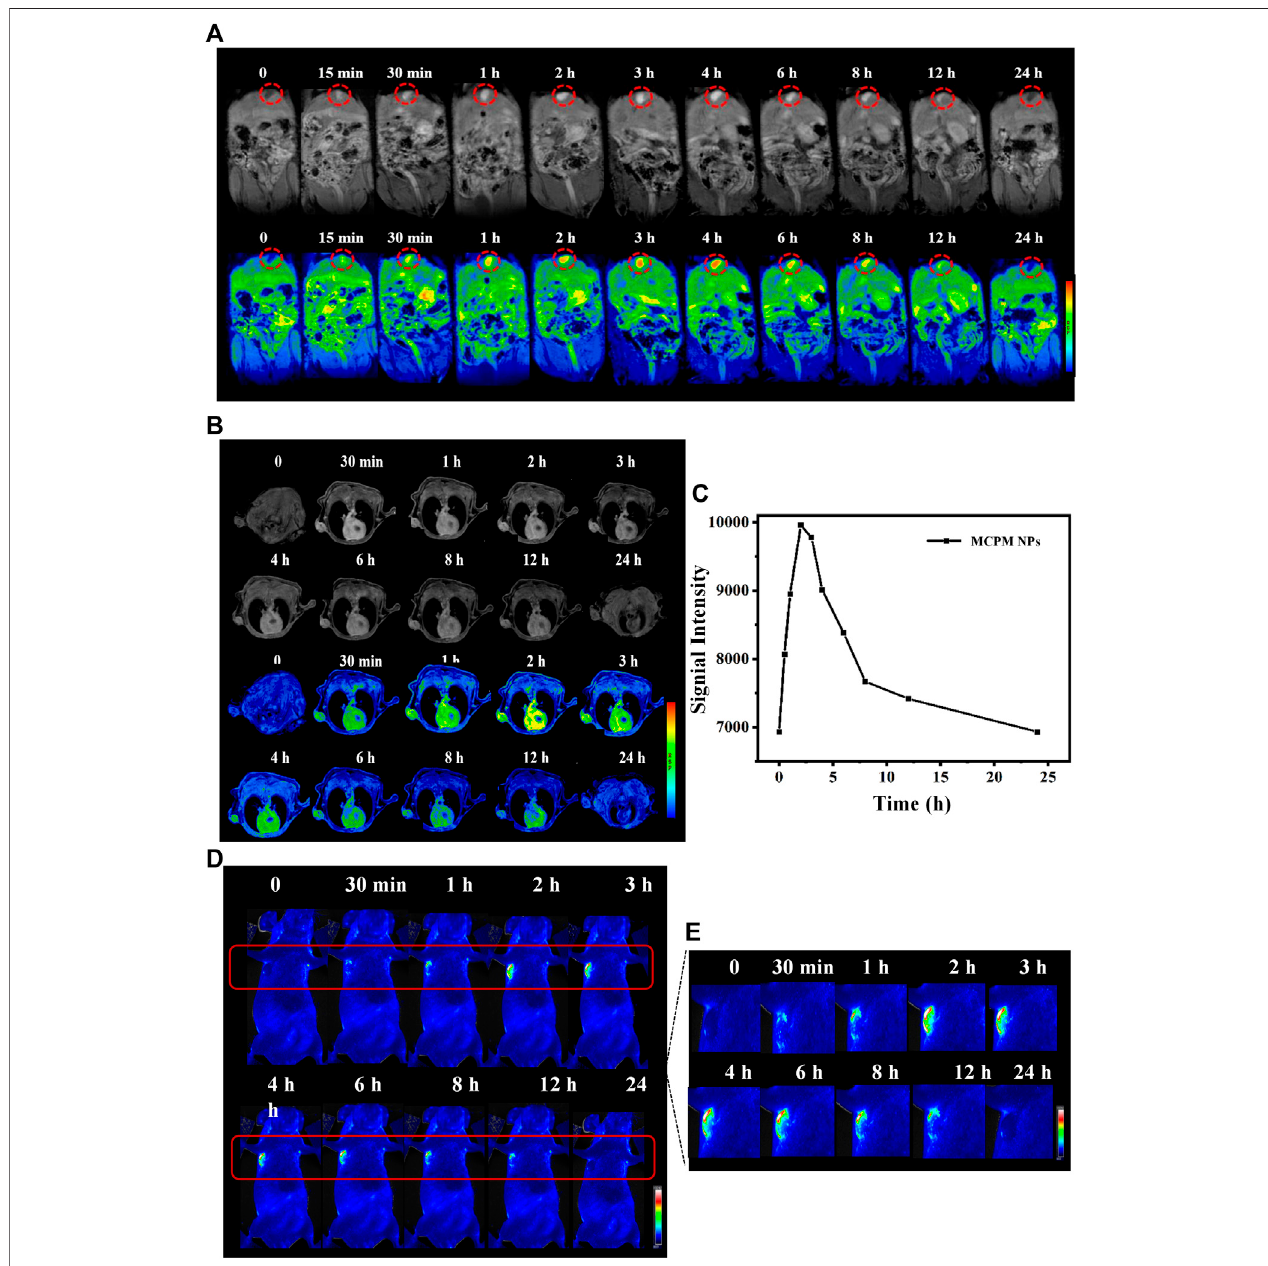
FIGURE7| MRI/FLabilityofMCPMNPs. (A) Invivo T 1 -weightedMRimagesandpseudo-colorimagesofmicewithsubcutaneousMDA-MB-231tumorafteri.v.injectionof MCPM NPs at different time points. Inside red circle is the gallbladder. (B) The corresponding changes in single intensities in the tumor areas. (C) In vivo FL images of mice with subcutaneous MDA-MB-231 tumor after i.v. injection of MCPM NPs at different time points. (D) The regions in red boxes in (C) were ampli fi ed and magni fi ed in the right panel.